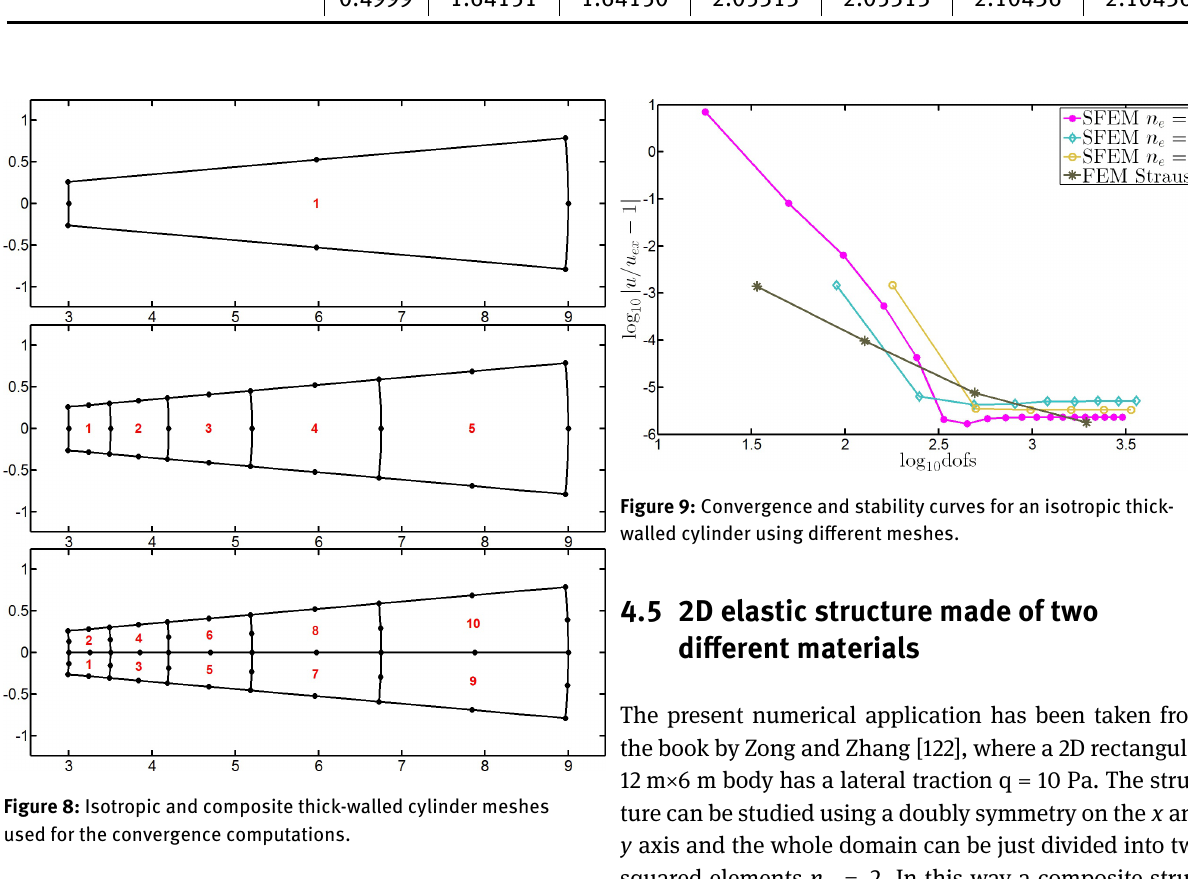
Figure 8: Isotropic and composite thick-walled cylinder meshes used for the convergence computations.